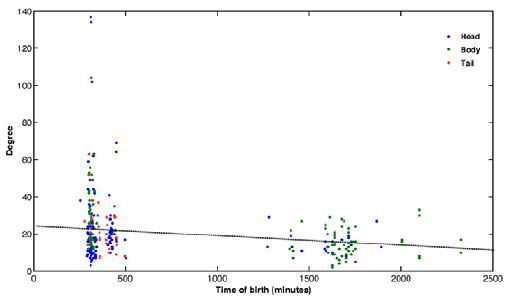
Figure 3. Node degree, the number of connections of a neuron, in relation to its time of origin and position in the nematode body, namely, Head, Body or Tail. Note that all nodes with more than 33 edges originate early during development. As would be expected the highest connectivity neurons are in the head. The dashed line represents the regression for a linear fit to the data. (Pearson’s correlation coefficient R= 2 0.24).